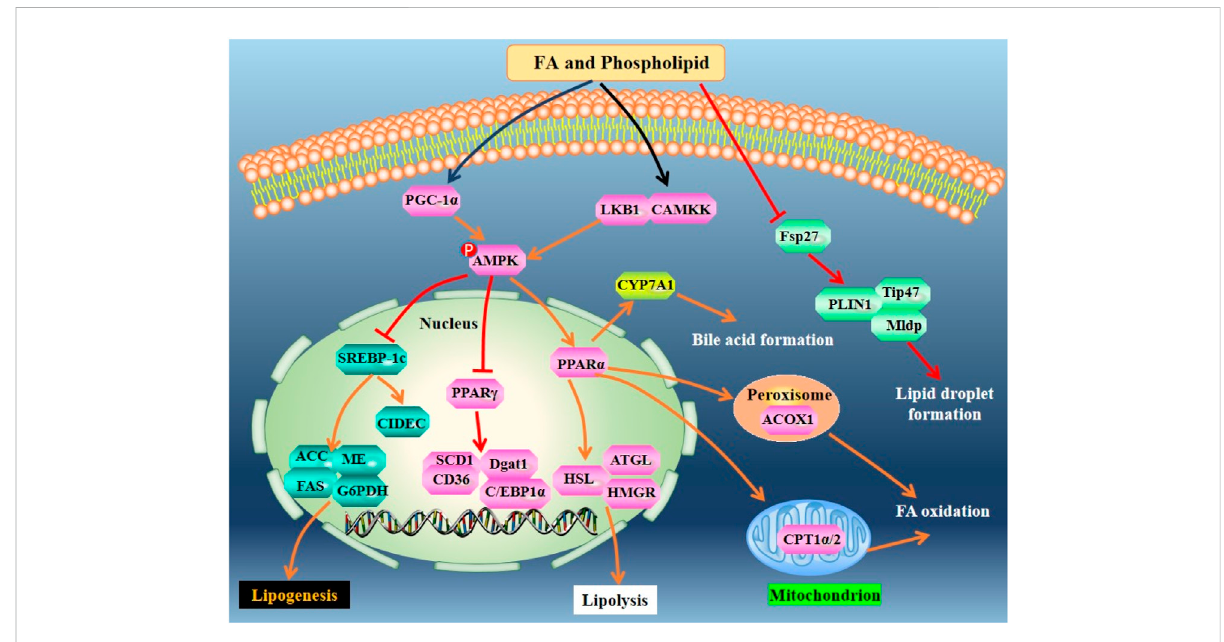
FIGURE 3 MechanismsofactionofFAandphospholipidderivedfromseacucumbers.CAMKK,Ca 2+ -dependentkinase;C/EBPs:CCAAT/enhancerbinding proteins; CIDEC: cell-death-inducing DFFA-like effector c; Dgat1, diacylglycerol acyltransferase 1; Fsp27, fat-speci fi c protein 27; HMGR: hydroxymethyl glutaric acid acyl; LKB1, liver kinase B1; Mldp, perilipin5; PLIN1, perilipin1; Tip47, perilipin 3. All the abbreviations are applicable for the rest Figures.